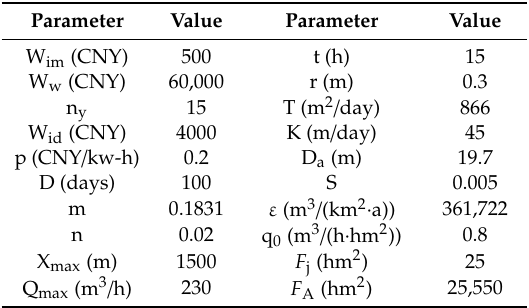
Table 2. Related parameters of the Cele